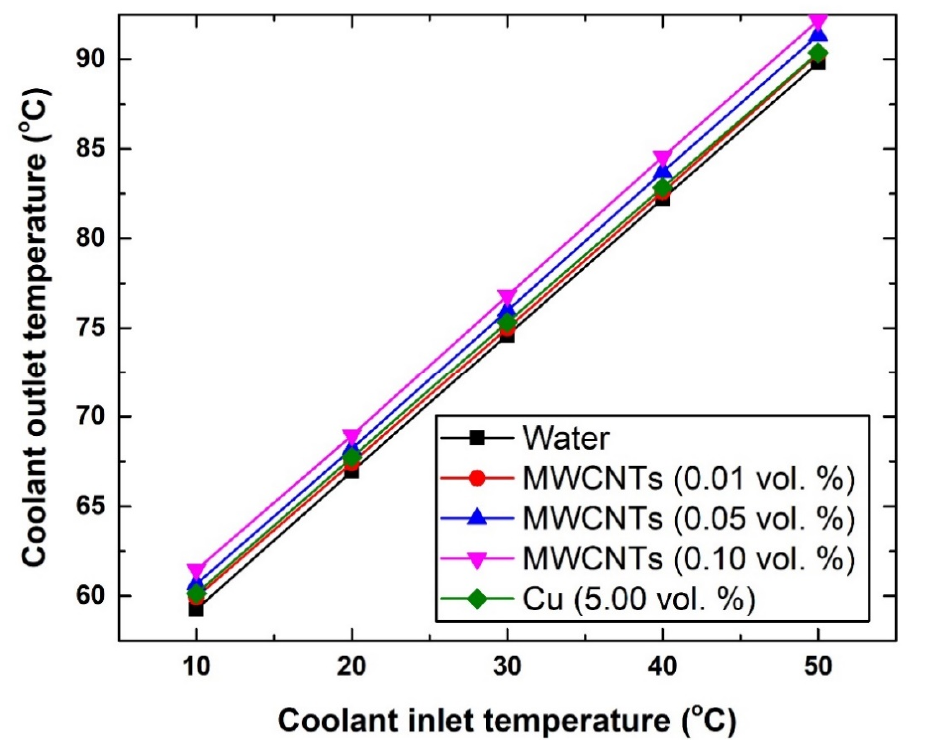
Figure 10. Changes in coolant outlet temperature with respect to coolant inlet temperature.